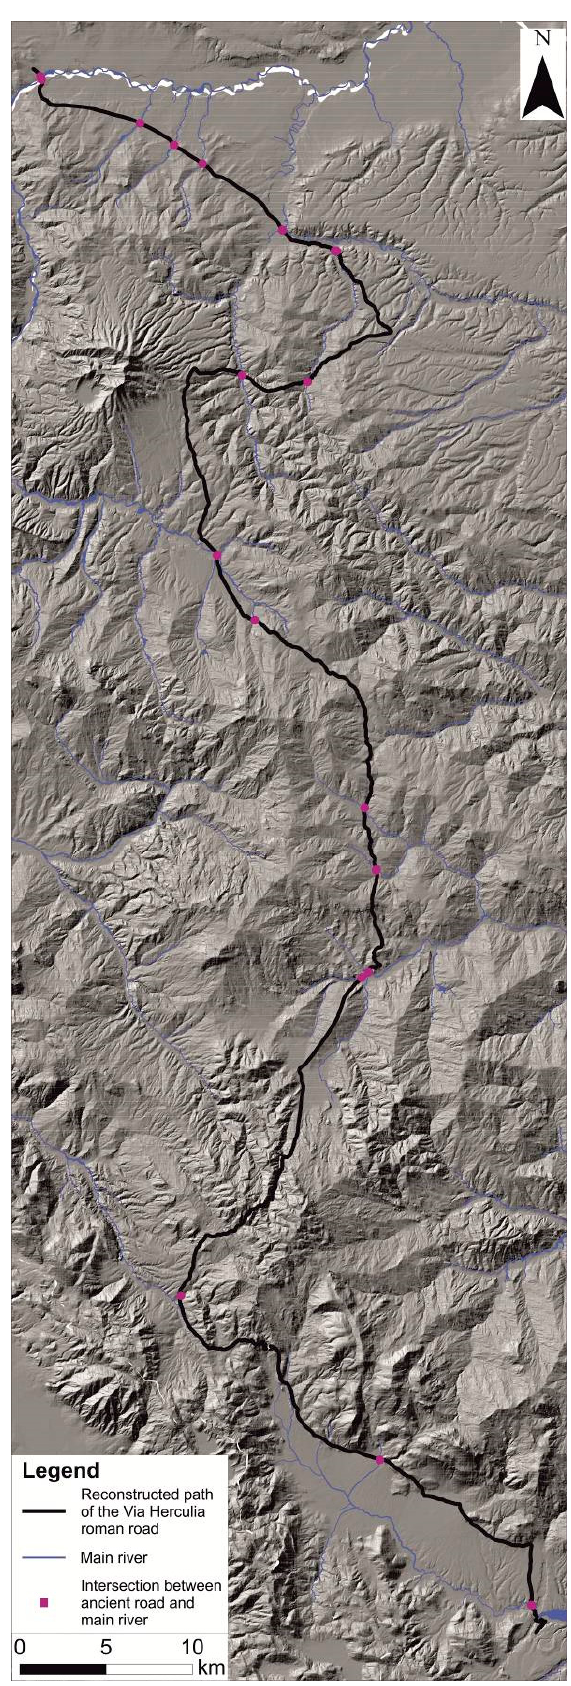
Figure 11. Topographic map of the final proposed route of the Via Herculia in Basilicata and interaction between the road and drainage network.